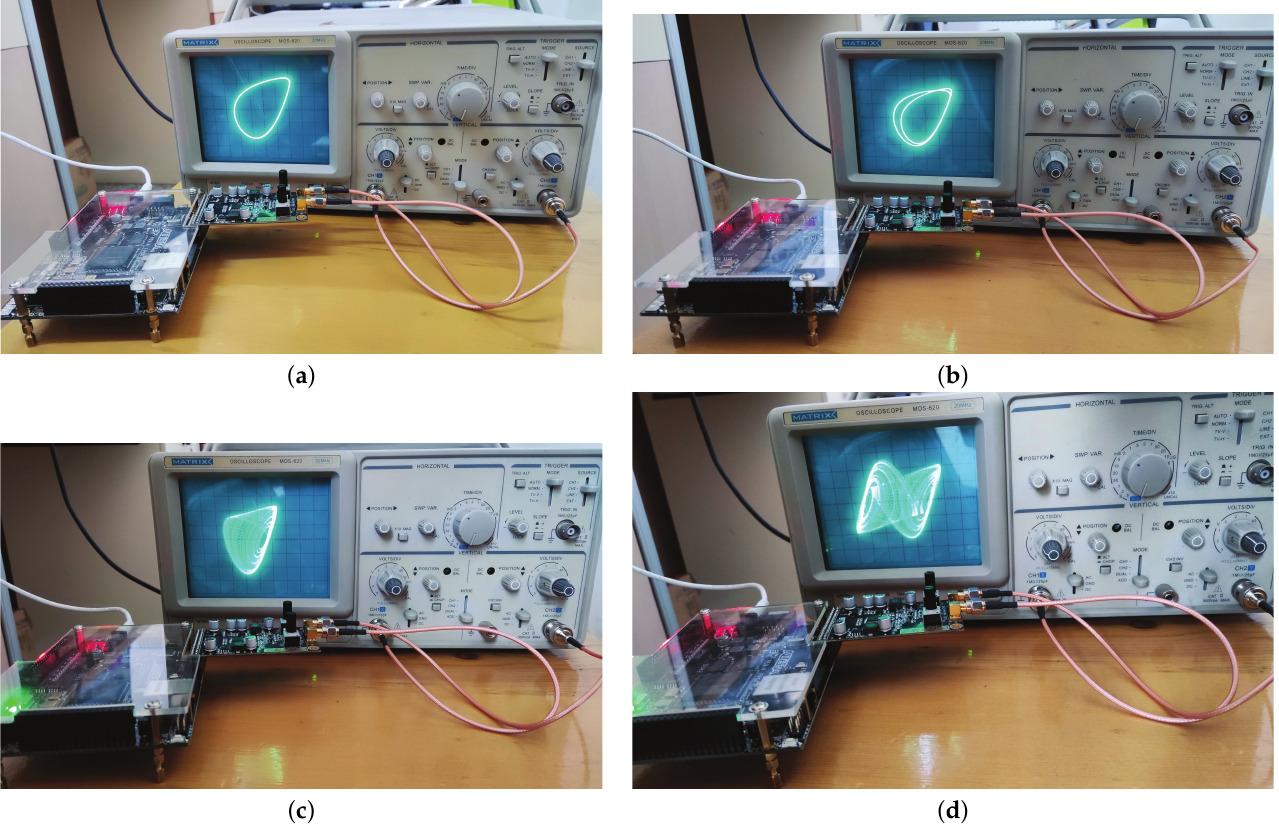
Figure 17. Experimental results of FPGA digital circuits of the fractional-order memristor system (15). ( a ) Single-scroll periodic-1 limit cycle with f = 23; ( b ) single-scroll periodic-2 limit cycle with f = 19; ( c ) single-scroll chaotic attractor with f = 13; ( d ) symmetric single-scroll chaotic attractor with f = 9.